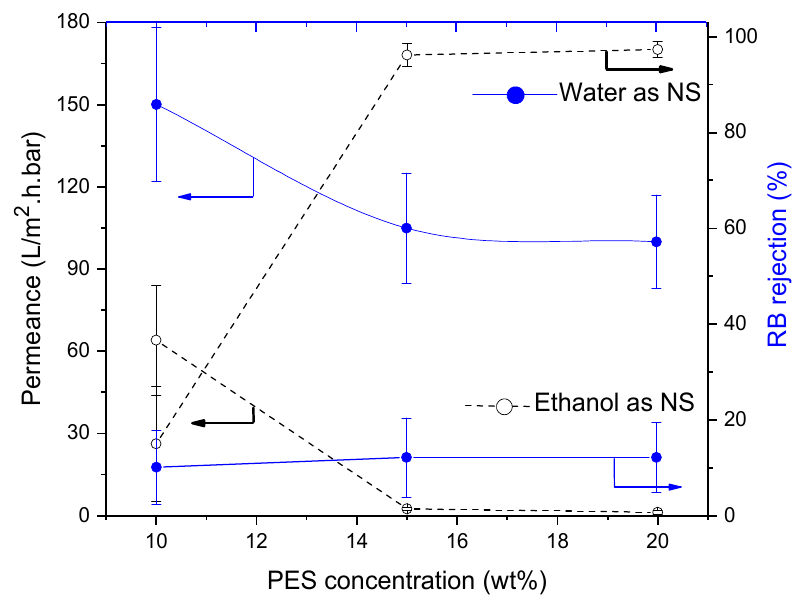
Figure 10. Influence of polyethersulphone (PES) concentration on membrane performance in term of RB rejection and permeance. Striped lines represent membranes prepared using ethanol as non-solvent and full lines those with water as non-solvent.